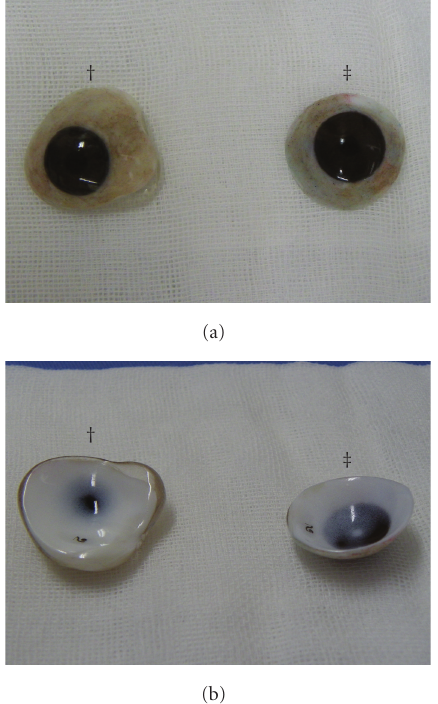
Figure 4: Preoperative (dagger) and final eye prosthesis (double dagger). Note thicker, malformed “sclera,” and nonconcentric “cor- nea”, preoperatively.